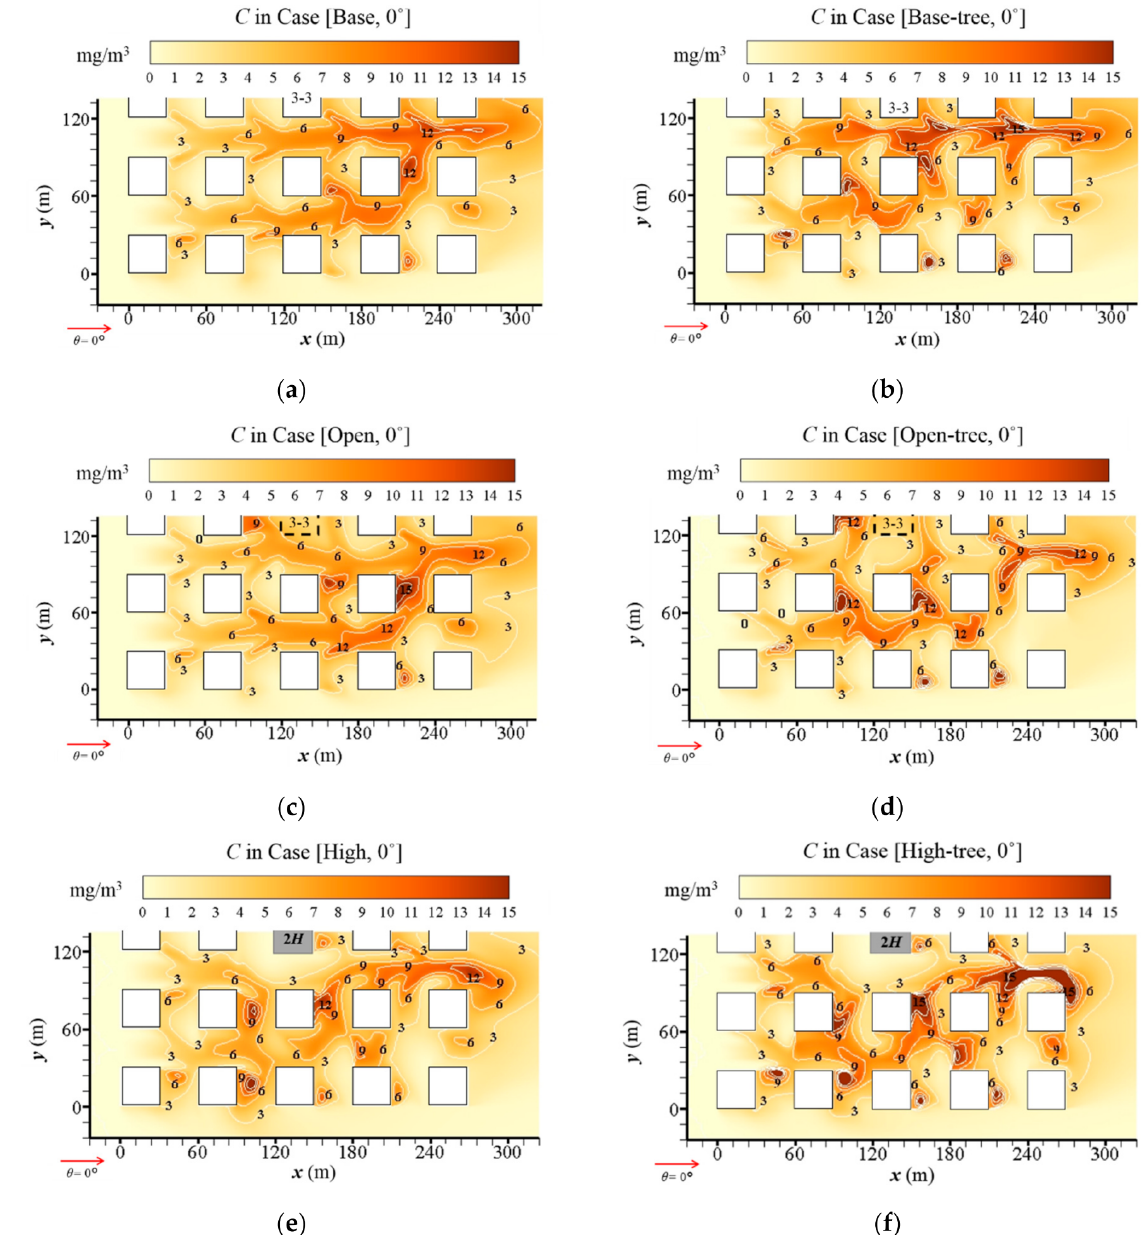
Figure 6. CO concentration ( C ) at z = 2 m in ( a ) Case [Base, 0 ◦ ], ( b ) Case [Base-tree, 0 ◦ ], ( c ) Case [Open, 0 ◦ ], ( d ) Case [Open-tree, 0 ◦ ], ( e ) Case [High, 0 ◦ ] and ( f ) Case [High-tree, 0 ◦